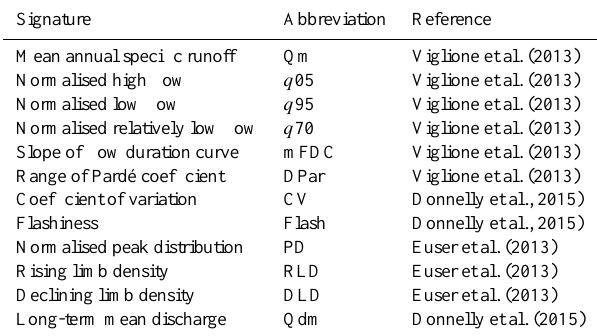
Table A1. Flow signatures used for model evaluation and catchment